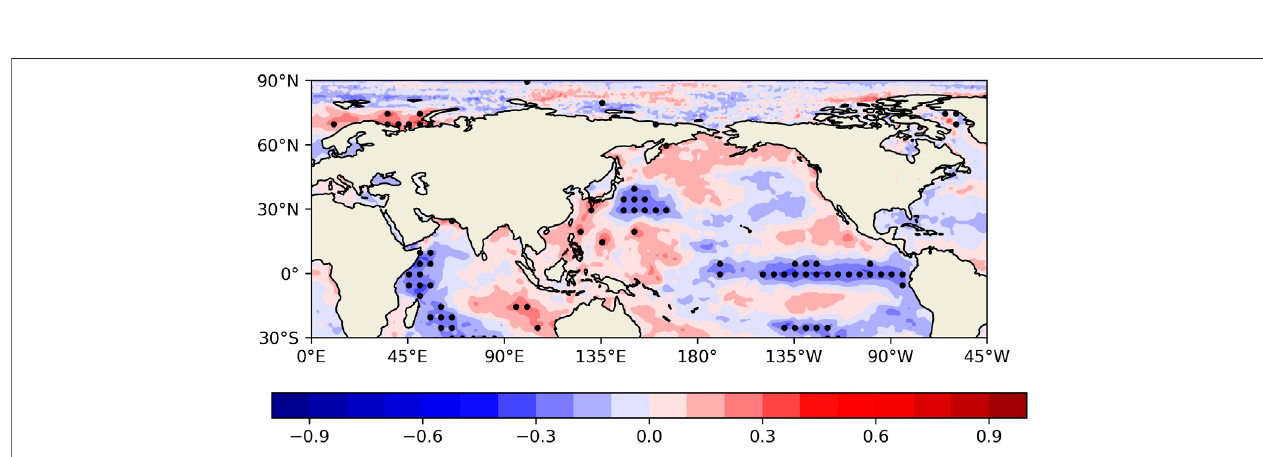
FIGURE 3 | Correlation coef fi cient between SST and precipitation in semi-arid regions in East Asia. Stippling denotes the region with statistical signi fi cance at the 90% con fi dence level based on Student ’ s t-test.